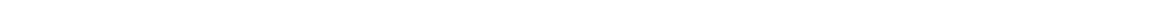
Fig. 8 Loss of Gon4l and excess epcam reduce notochord boundary tension. a Diagram of laser ablation experiments to measure tension at axial mesoderm cell interfaces. b Still images from confocal time-lapse movies of each of the three types of cell interfaces (Edge, V junctions, and T junctions) before and after laser ablation. Arrowheads indicate cell vertices adjacent to the ablated interface. Images are representative of 36 independent experiments. c – e Quanti fi cation of cell vertex recoil distance immediately after laser ablation of Edge ( c ), V junction ( d ), and T junction ( e ) interfaces at the time points indicated in WT, MZ udu − / − , WT epcam overexpressing, and WT itga3b -overexpressing gastrulae. Symbols are means with SEM. Asterisks are colored according to key and indicate signi fi cant differences compared to WT controls (two-way ANOVA, **** p < 0.0001, ** p < 0.01). f – g Quanti fi cation of notochord boundary straightness in WT itga3b ( f ) or epcam ( g ) overexpressing embryos with or without Calyculin A (two-way ANOVA, **** p < 0.0001, *** p < 0.001). N indicates the number of embryos analyzed, symbols are means with SEM. h Graphical model of the roles of Gon4l and PCP signaling